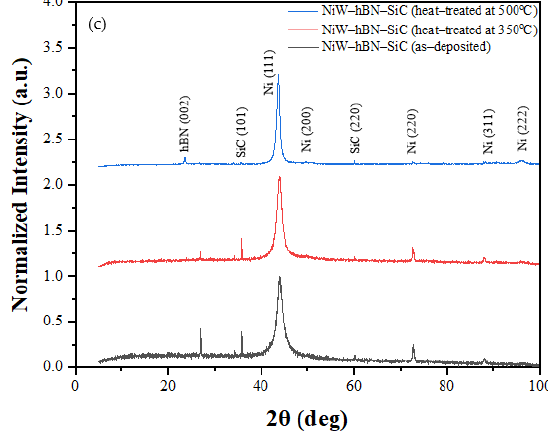
Figure 12. XRD spectra from the surface of, respectively, as-deposited, heat-treated at 350 °C and heat treated at 500 °C of DC electrodeposits: NiW( a ), NiW–hBN ( b ), and NiW–hBN–SiC ( c ). Table 4. Crystallite sizes of DC-deposited NiW, NiW–hBN, and